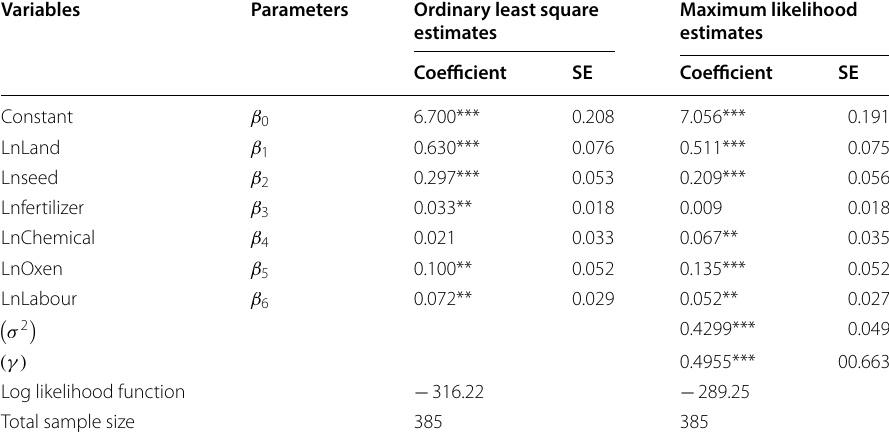
***, **Show significance at 1% and 5%, respectively